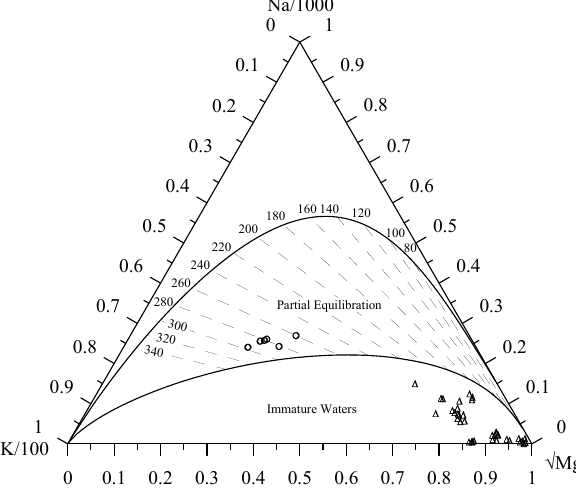
Figure 3. Southeastern Idaho waters from hot springs and wells plotted on Giggenbach diagram (Giggenbach, 1988). All partially equilibrated waters are of Na-Cl (Group I) type